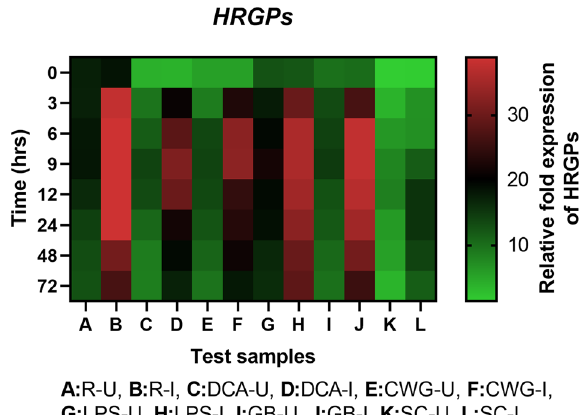
Figure 12. qRT-PCR determined relative expression of HRGPs genes in 2-day-old P. glaucum seedlings with (I) or without (U) Sclerospora graminicola inoculation harvested 0, 3, 6, 9, 12, 24, 48, and 72 h. R—resistant, S— susceptible, DCA—3,5-Dichloroanthranilic acid treated, CWG—Cell Wall Glucans isolated from the endophyte Trichoderma hamatum UOM 13, LPS—Lipopolysaccharides isolated from bacteria Pseudomonas fluorescens UOM 14, GB—Glycinebetaine an amino acid derivative. Expression levels were measured by qPCR and normalized to the constitutive PP2A gene. Values are means of experiments carried out in four replicates. The bars indicate ± SE and the data were analyzed by one-way ANOVA followed by Tukey’s test and p ≤